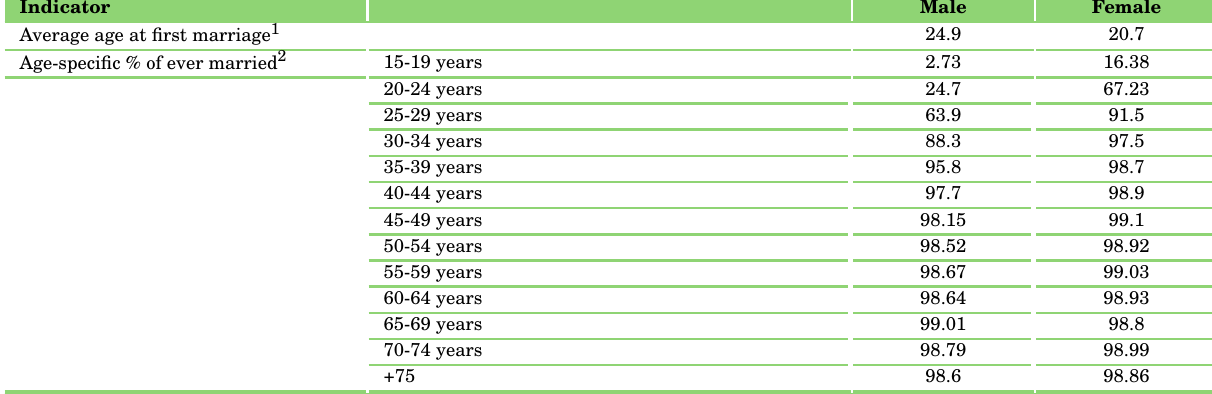
Table 42: Marriage patterns in India